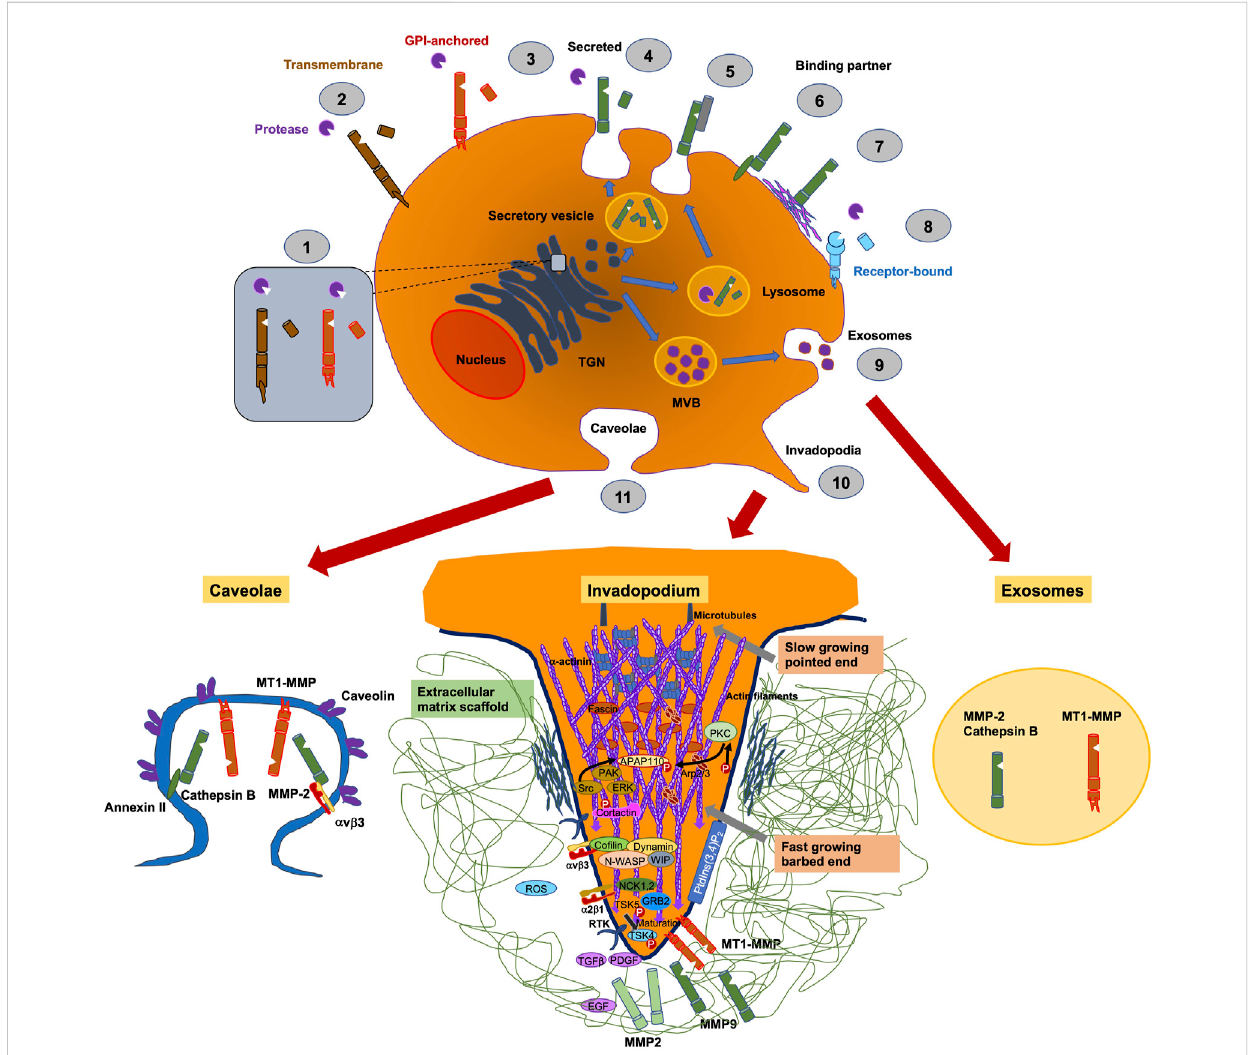
FIGURE 2 Pericellularproteases,suchasADAM8,areinvolvedintraf fi ckingofproteins.TheyaresynthesizedintheERandgettransferredtotheGolgicomplex until they enter the trans-Golgi-network (TGN). (1) In the TGN membrane, attached proteases are switched active through furin. (2) Membrane-bound proteasesaredeliveredtothecellsurface,wherebytheyareinactiveprecursorproteinsandbecomeactivewithintheperivascularcavity.(3)Traditionally, secreted proteases are transported to the cell membrane via a constitutive secretory pathway and activated after their liberation in the pericellular cavity. Proteases in endosomes or lysosomes are transported to the extracellular cavity by different pathways: (4) the secretory pathway, where they are secreted as proenzymes that must be activated by proteolysis, or (5) the mechanism of lysosomal exocytosis, where they are activated and thereafter secreted.Secretedproteasescanbindtothecellsurfacethroughinterferencewithothermolecules,includingCD44,integrinsor(6)annexinIIorthrough (7) tethering to ECM compounds. (8) Speci fi c secreted proteases are attached to distinct receptors, for example, uPA couples to uPAR. (9) Proteases are capable to be liberated through exosomes originating from multivesicular bodies (MVBs), where they can be released into the extracellular cavity or into neighboring cells. The aggregation or the regional liberation of pericellular proteases are linked to microdomains on cell membranes, such as invadopodia, which are actin-rich moieties (10) or caveolae, which belong to “ lipid raft ” domains